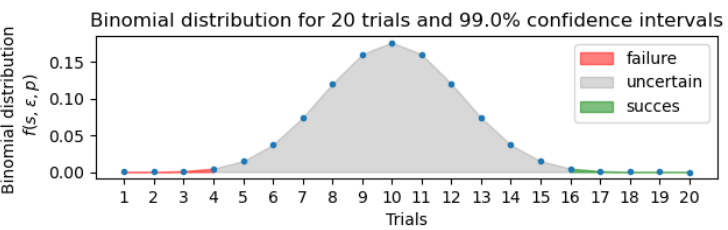
Figure 1. Example of a decision-making process for 20 trials according to Equation (3). Using 20 trials, the feature can be labeled as important if it scores higher than shadow features at least 16